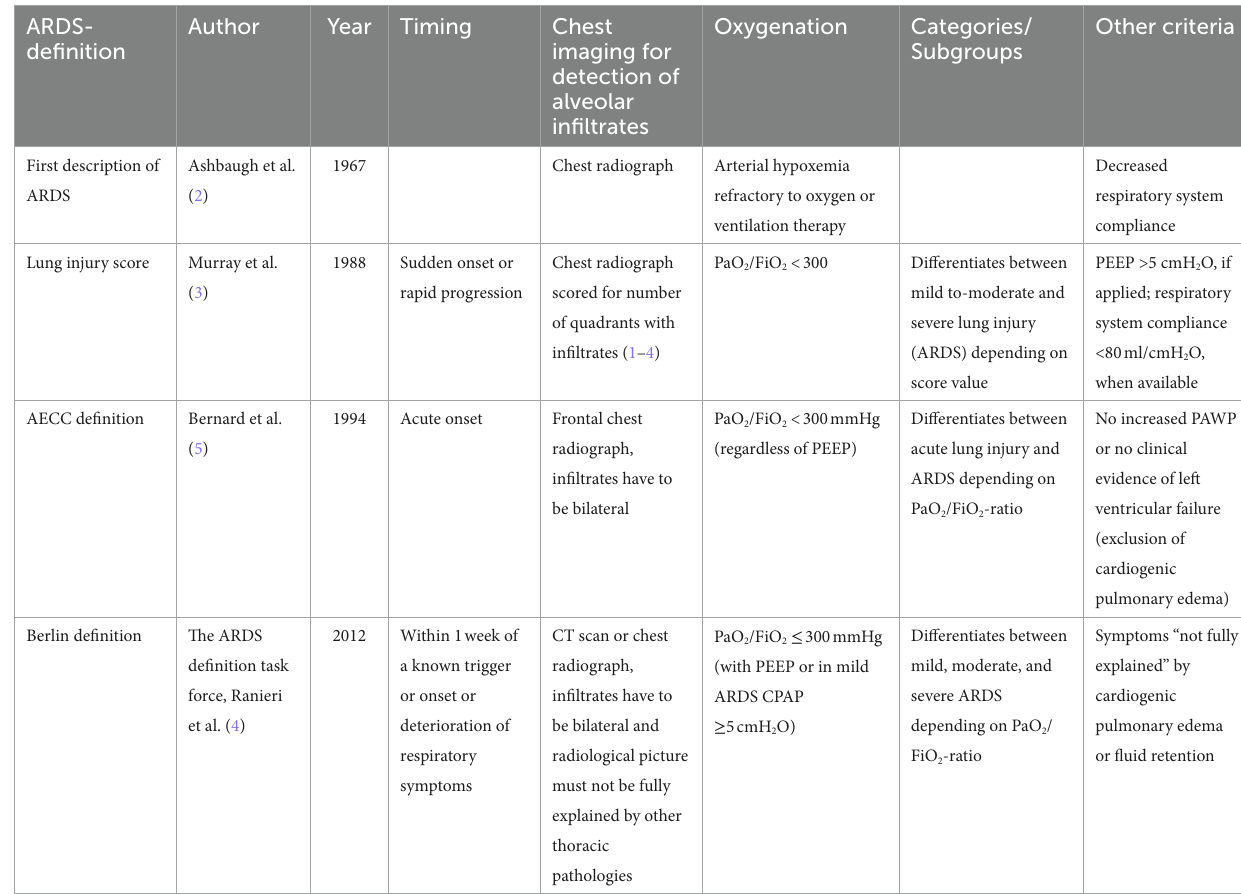
TABLE 1 Overview of the definitions for acute respiratory distress syndrome